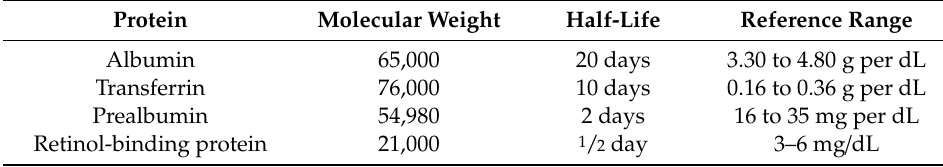
Table adapted from Spiekerman AM